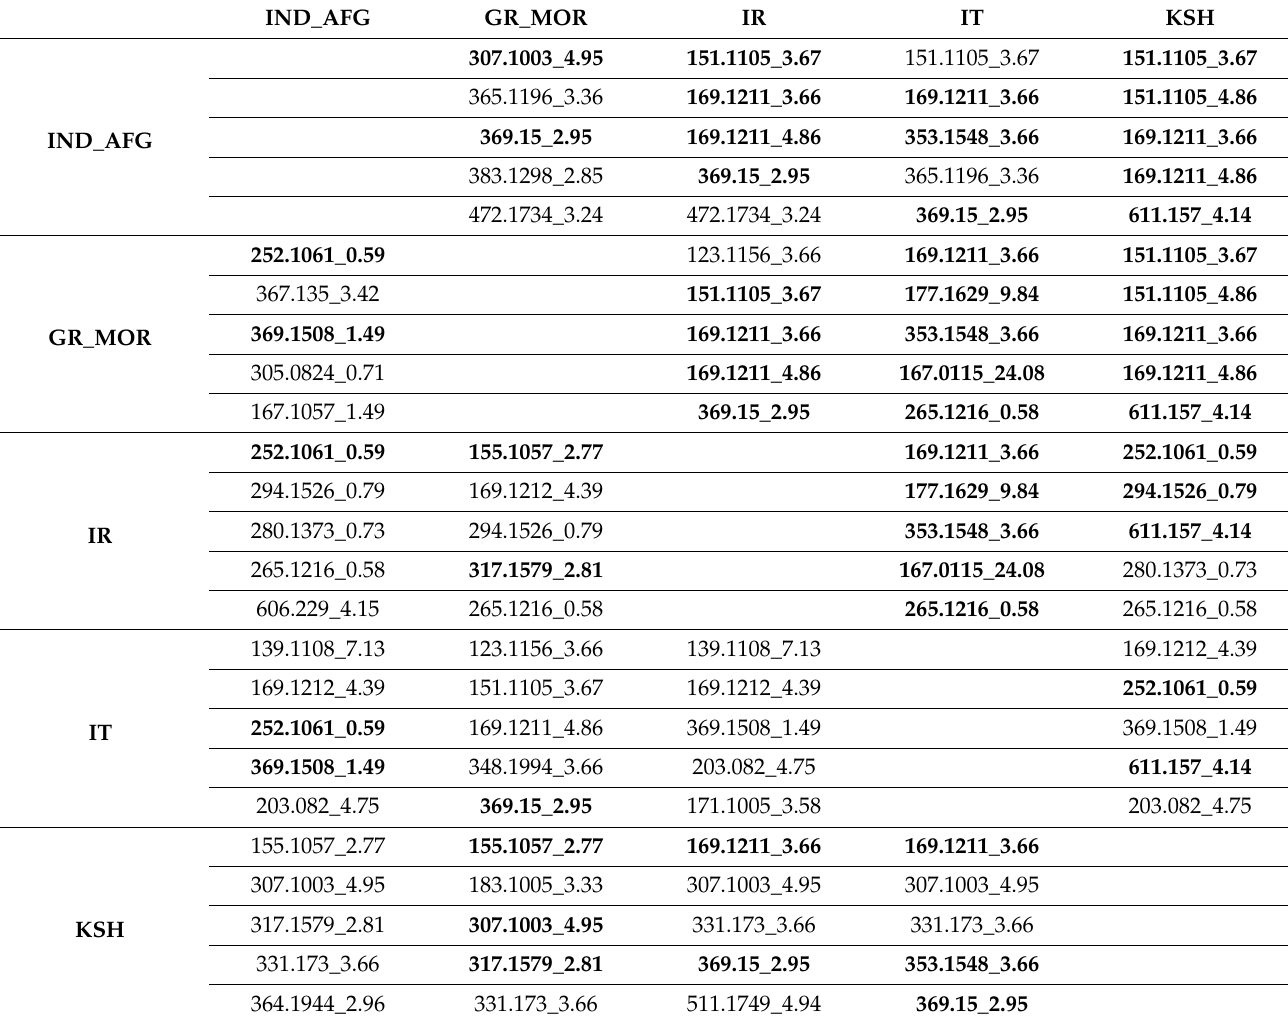
Table 2. Markers discovered towards the differentiation of the Crocus sativus L. stigmas from various destination sources. In bold are marked the common metabolites across at least two destination sources whereas underlined are the ones that could differentiate between all